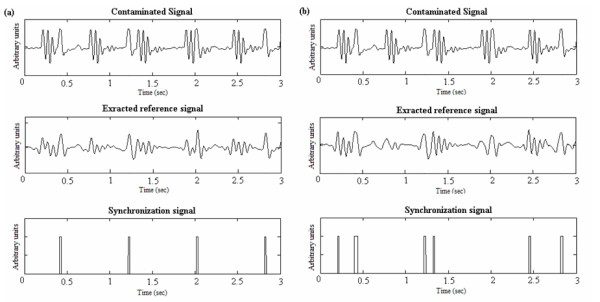
Wavelets performances difference. QRS detection for "75 bpm" signal recorded during the IRSE sequence: the same signal is decomposed using coif5 and sym5. One can clearly notice the superiority of coif5 (a) (that ensured perfect detection), to sym5 (b) (that detected 3 false peaks and missed one QRS).